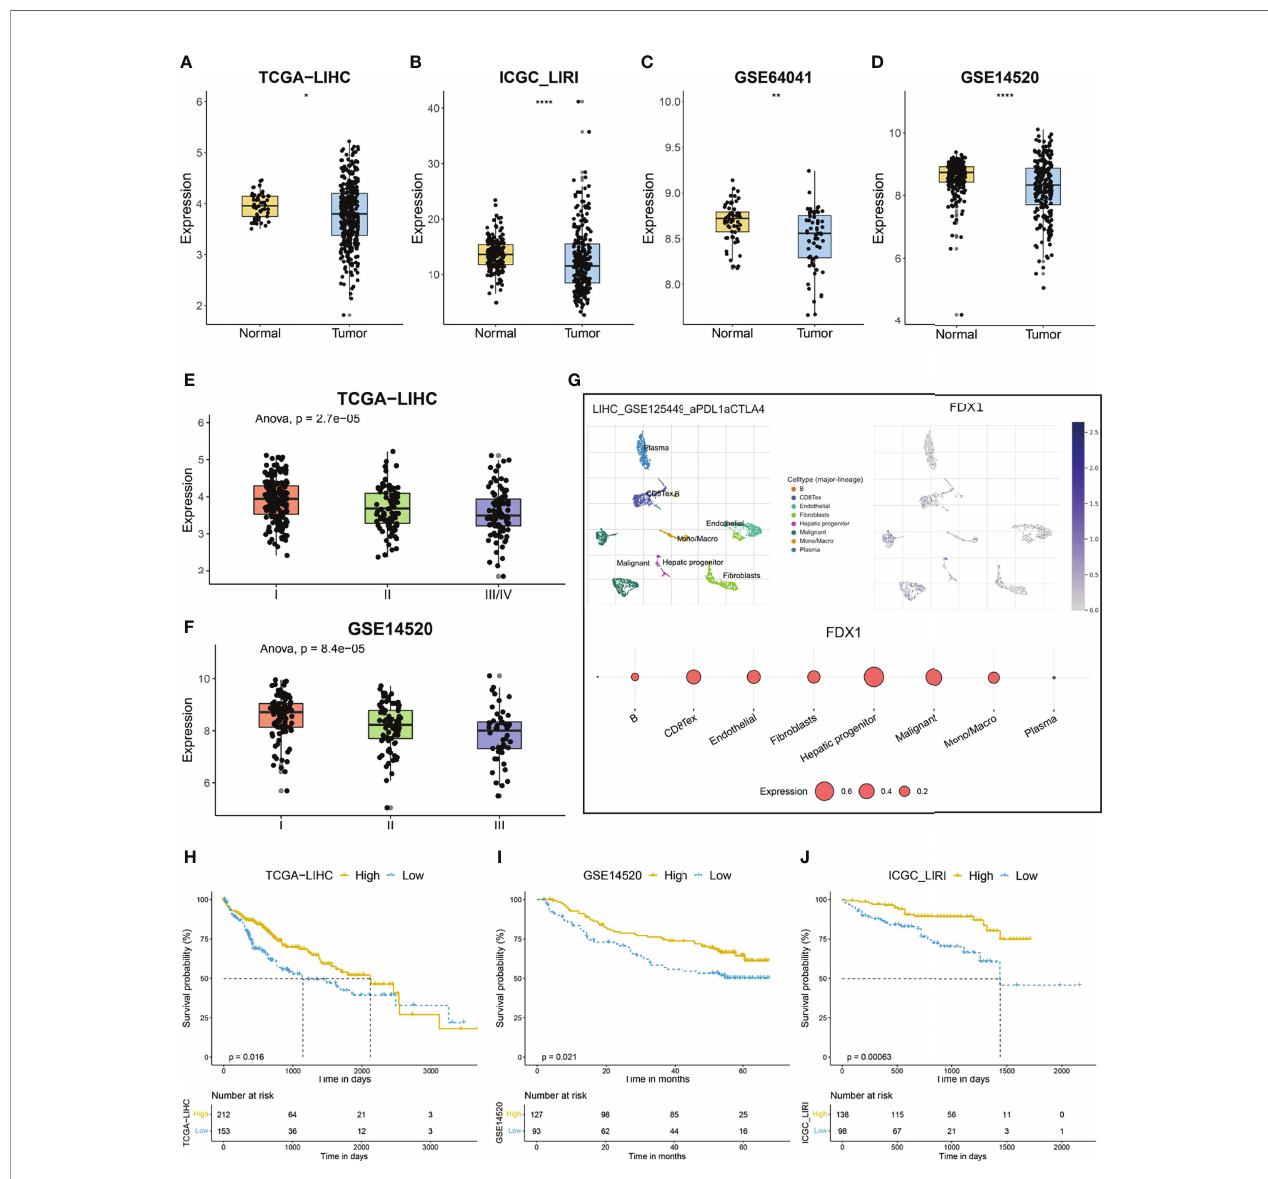
FIGURE 1 | The expression and prognostic signi fi cance offerredoxin 1 ( FDX1 ) in hepatocellular carcinoma (HCC). (A – D) The box and dot plot showing the expression of FDX1 between tumor and corresponding normal tissues in TCGA-LIHC (A) , ICGC-LIRI (B) , GSE64041 (C) , and GSE14520 (D) cohorts. Wilcoxon test was used for data analyses. (E, F) The box and dot plot showing the expression of FDX1 in HCC patients with different clinical stages in TCGA-LIHC (E) and GSE14520 (F) cohorts. ANOVA test was used for data analyses. (G) The expression of FDX1 in each type of cell in the GSE125449 dataset. The upper left t-SNE subgraph reveals the distribution of eight types of cells from HCC patients (indicated by colors). The upper right subgraph showed the relative expression of FDX1 in each cell. The lower subgraph showed the relative expression of FDX1 in eight types of cells. (H – J) The prognostic signi fi cance of FDX1 in TCGA-LIHC (H) , GSE14520 (I) , and ICGC-LIRI (J) cohorts. Based on the optimal cutoff value of FDX1 , about 58% (212/365) of the HCC patients in TCGA-LIHC were divided into high- FDX1 subgroup and the remaining patients were in the low- FDX1 subgroup. In the validating datasets (GSE14520 and ICGC_LIRI), 58% of HCC patients were also classi fi ed into the high- FDX1 subgroup according to the expression of the gene. The Kaplan – Meier method was used for prognosis analysis. The p values were shown as *p < 0.05, **p < 0.01 and ****p <